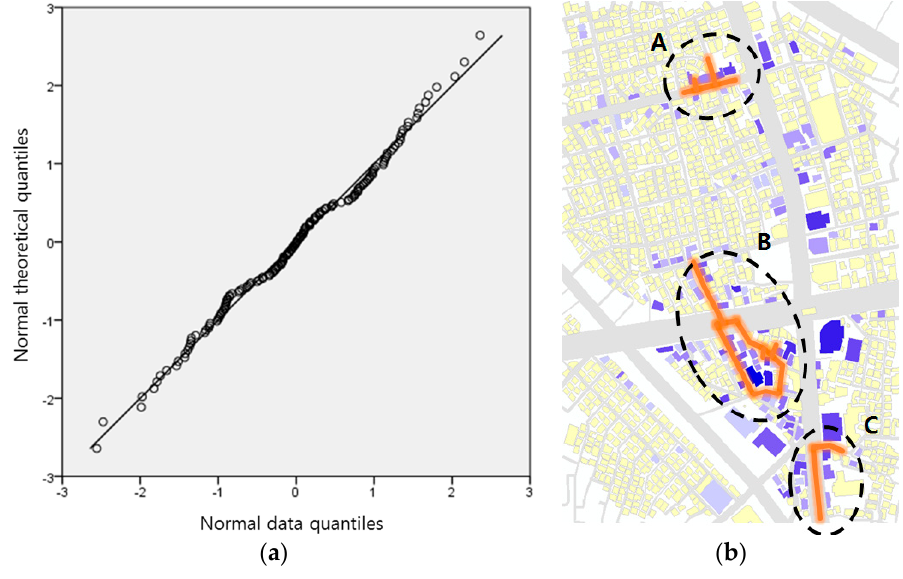
Figure 8. Sillim test area results: ( a ) Q-Q plot for normal; ( b ) Restaurant themed streets.